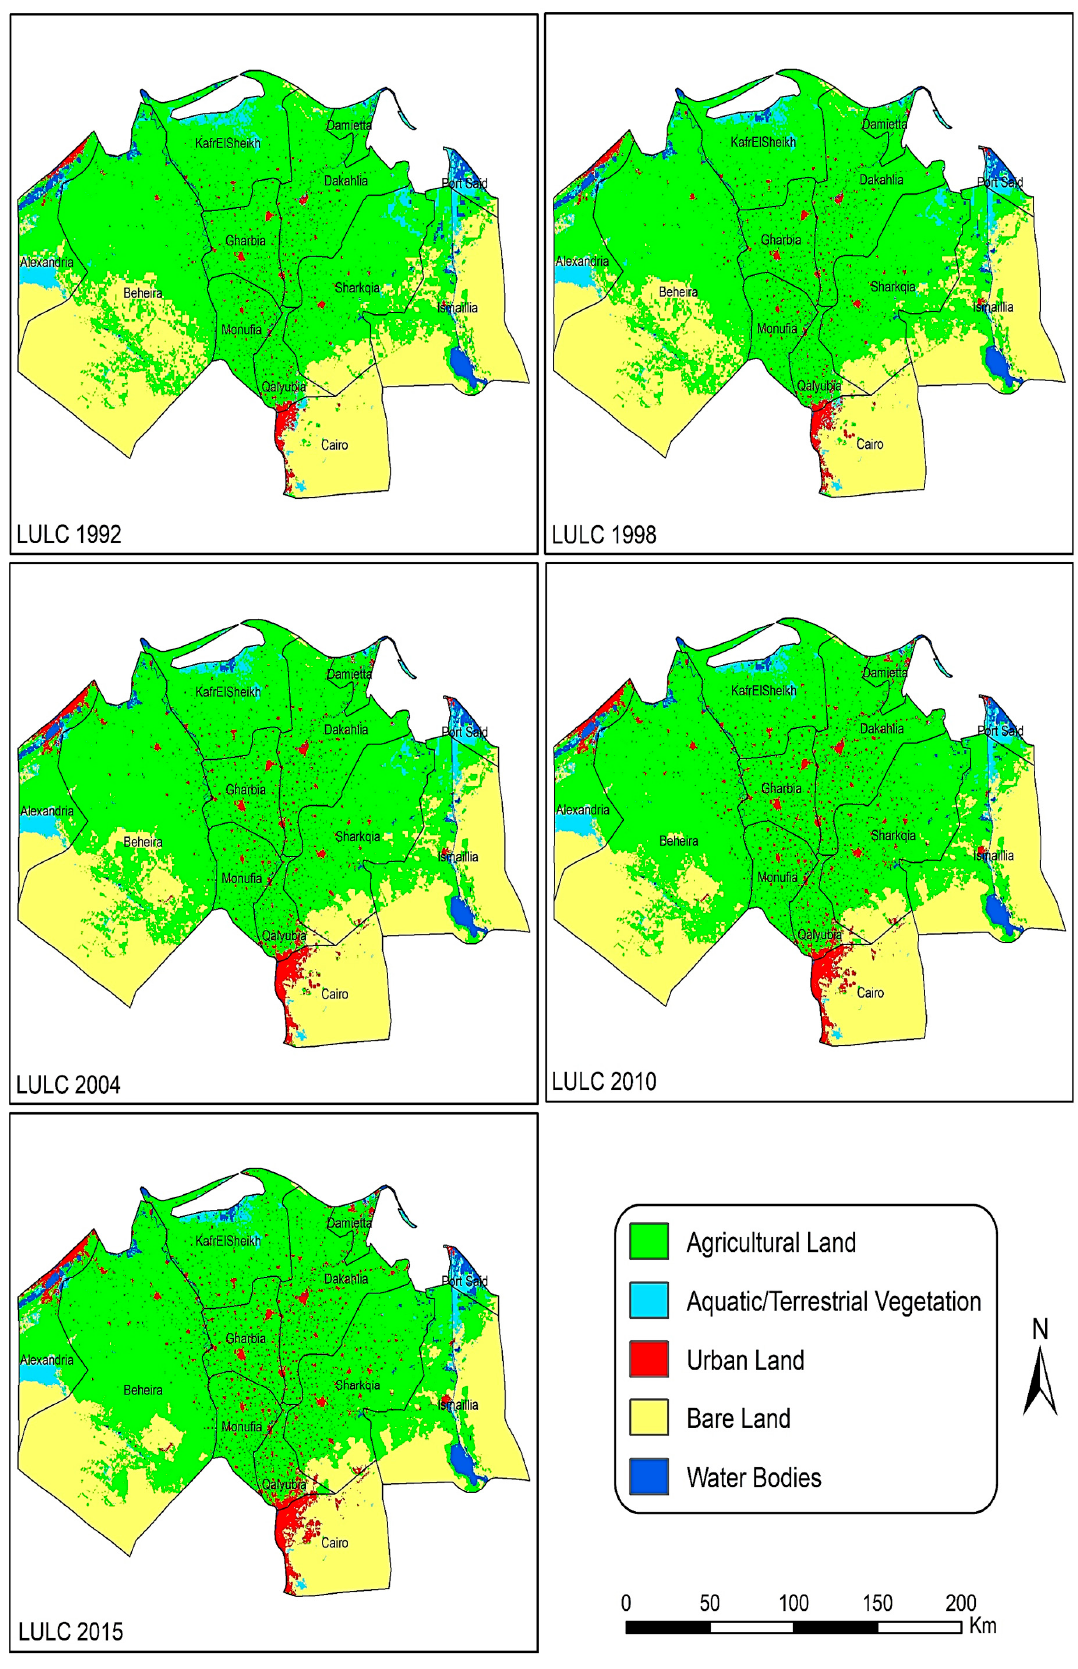
Figure 4. The major five LULC classes in the Nile Delta over the study period.